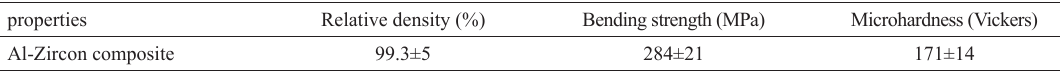
Table 1: Relative density, bending strength and microhardness of prepared composite. properties